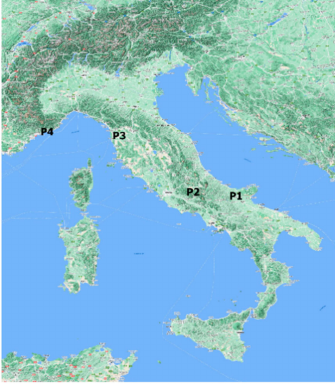
Figure 1. Location of the four PV plants used in the study.